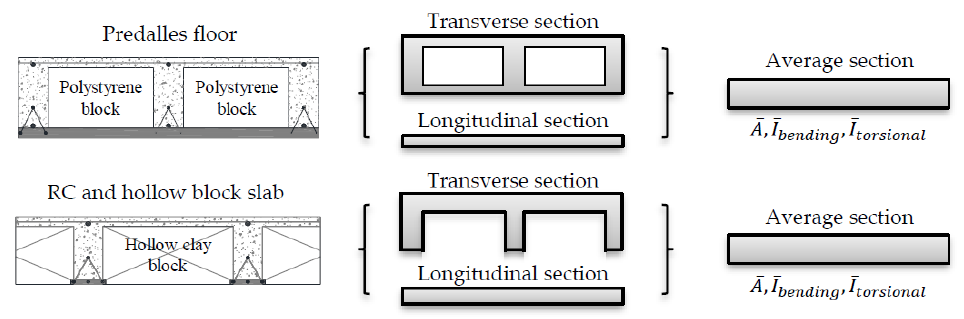
Figure 8. Modelling strategies for the floor slabs.